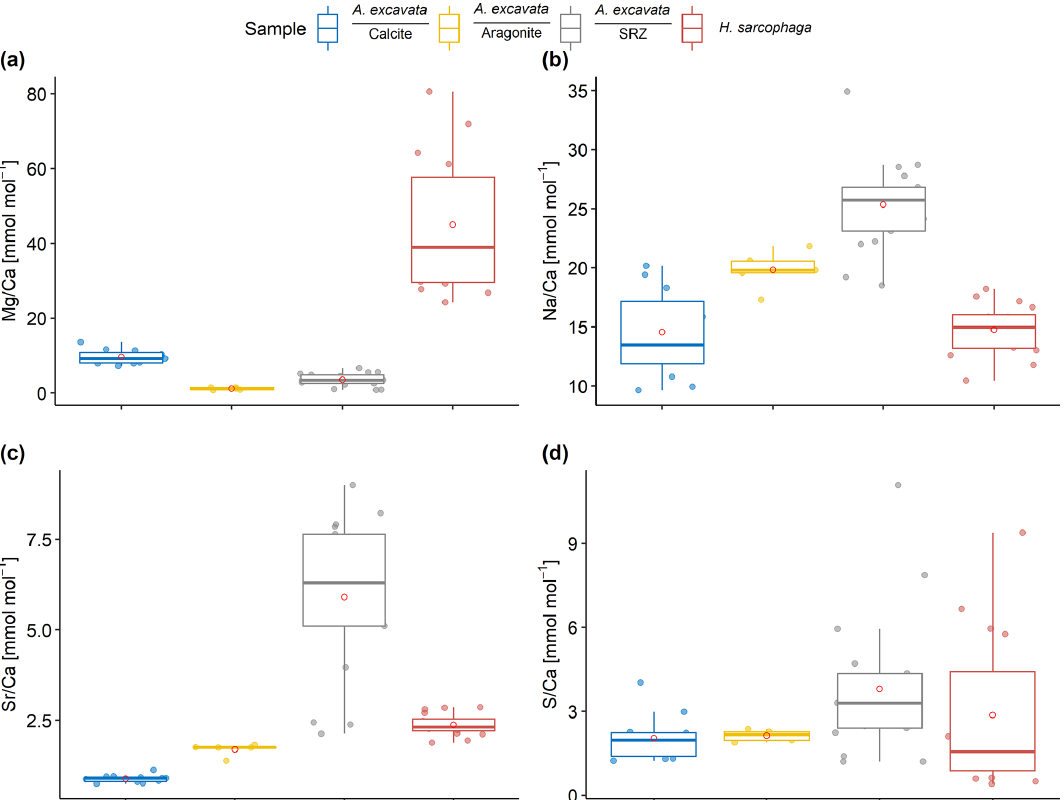
Figure 2. Results of point measurements by EPMA in different sections of A. excavata and H. sarcophaga (two specimens each). (a) Mg / Ca, (b) Na / Ca, (c) Sr / Ca and (d) S / Ca. Boxes display the interquartile range (IQR) and lines the median values. The whiskers show minimum and maximum values that are within the range of Q1 − 1.5 × IQR – Q3 + 1.5 × IQR. Red circles show the mean values. Sample size = 11, 5, 17 and 16 (calcite, aragonite, SRZ, H. Sarcophaga ). Text below the horizontal lines in the legend is the sampled